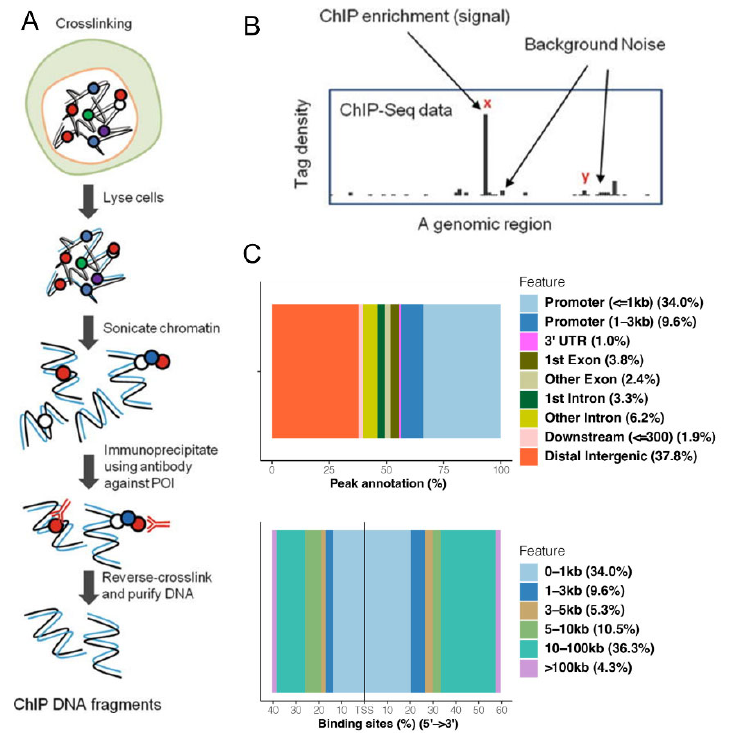
Figure 1. HO-1 ChIP-seq flowchart and binding to DNA. ( A ) Protocol for ChIP-seq. ( B ) Meaning of enriched peaks, or hits, in ChIP-seq data. ( C ) HO-1 DNA peak locations (distribution of peaks inside genomic features (top) or peak distance from transcription start site (bottom)) showing that majority of HO-1-specific peaks are either less than 1 KB from a promoter/Transcriptional Start Sites (TSS) or in distal intergenic regions (10–100 kb from promoter/TSS).